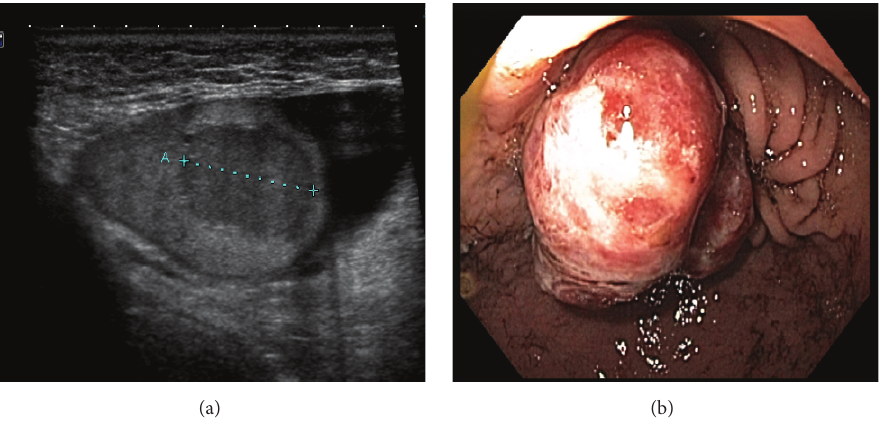
Figure 1: (a) Ultrasound showing testicular metastasis of RCC; mass measuring 2.1 × 1.7 × 2.0 cm. (b) Endoscopy showing metastatic RCC mass to the fundus of the